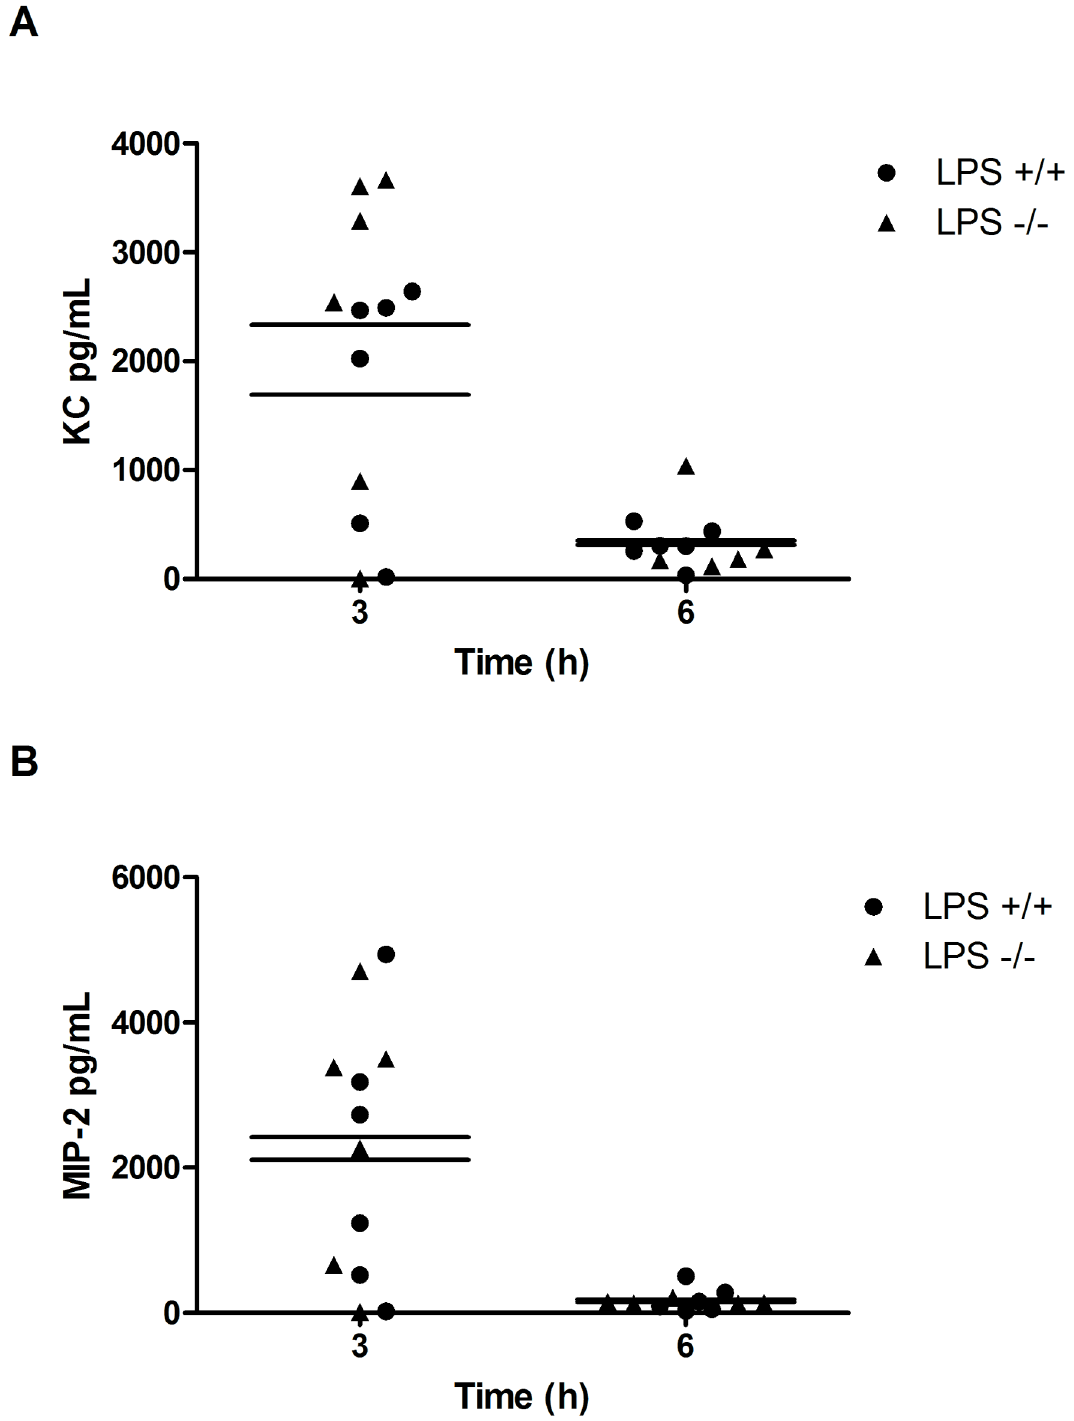
Fig 4. Cytokine levels are similar between LPS-exposed Duoxa +/+ and Duoxa - /- mice. BALF was collected at various timepoints from Duoxa +/+ (+/+) and Duoxa - /- (-/-) mice followed by measurement of KC (A) or MIP-2 (B) cytokine levels in the supernatant by ELISA. Cytokine concentration was determined by comparison to standard controls for each cytokine. Data from six animals in each group are shown. Mean cytokine values from Duoxa +/+ (+/+) and Duoxa - /- (-/-) mice are shown as a vertical line. Cytokine levels for LPS treatment differed significantly than PBS controls at three hours in both groups of mice (data not